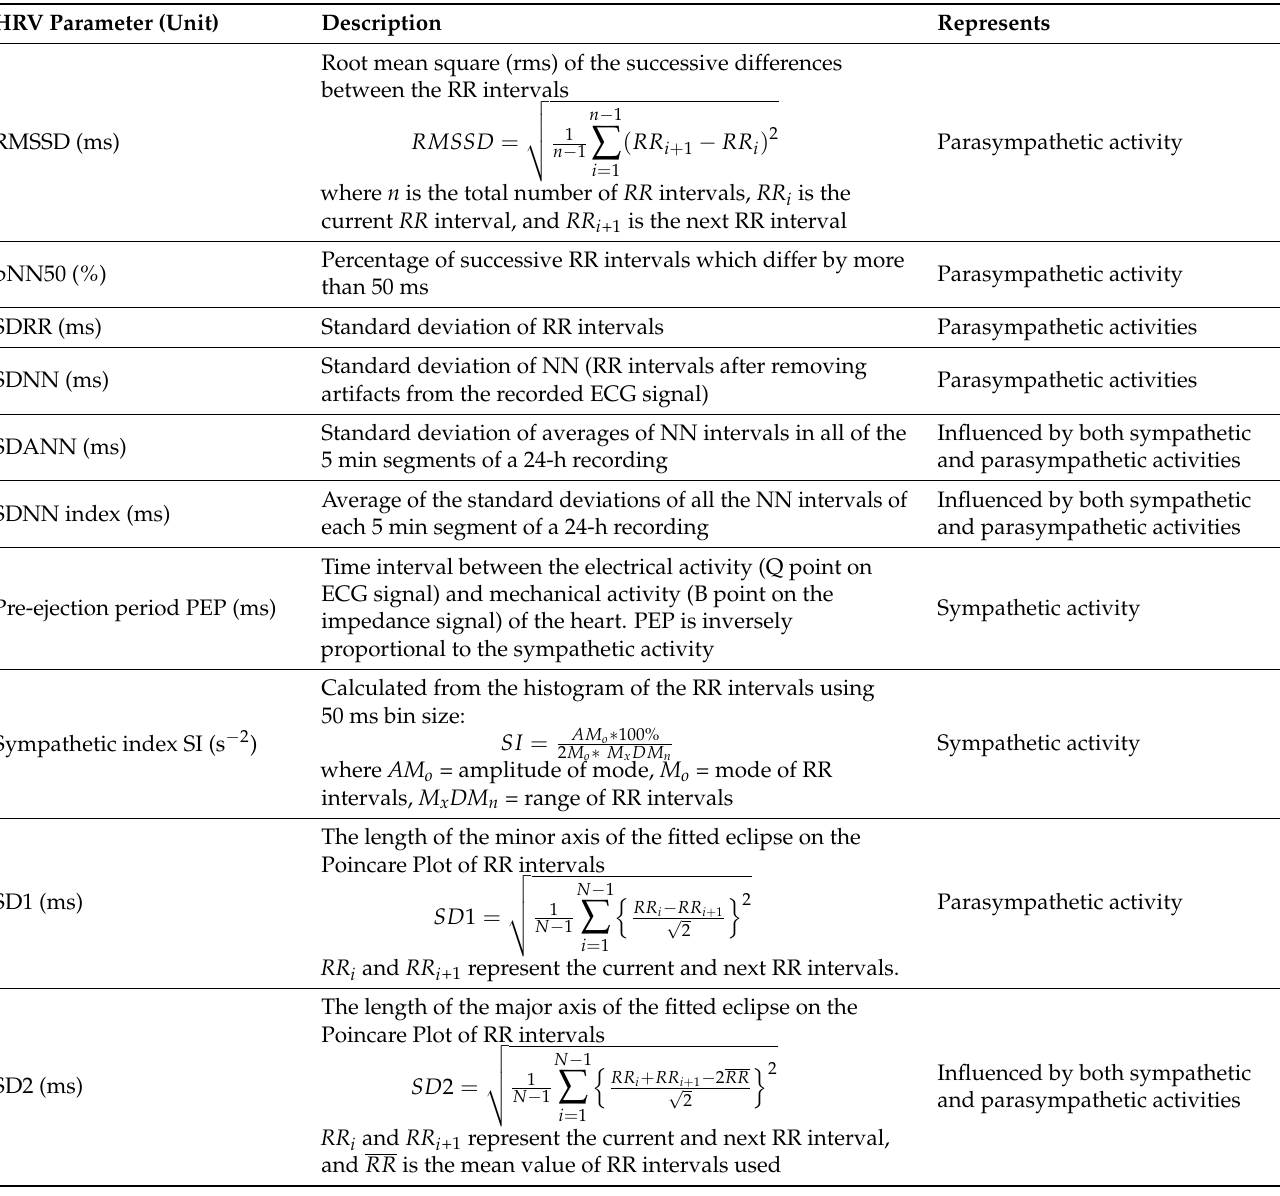
Table 1. Heart rate variability (HRV)